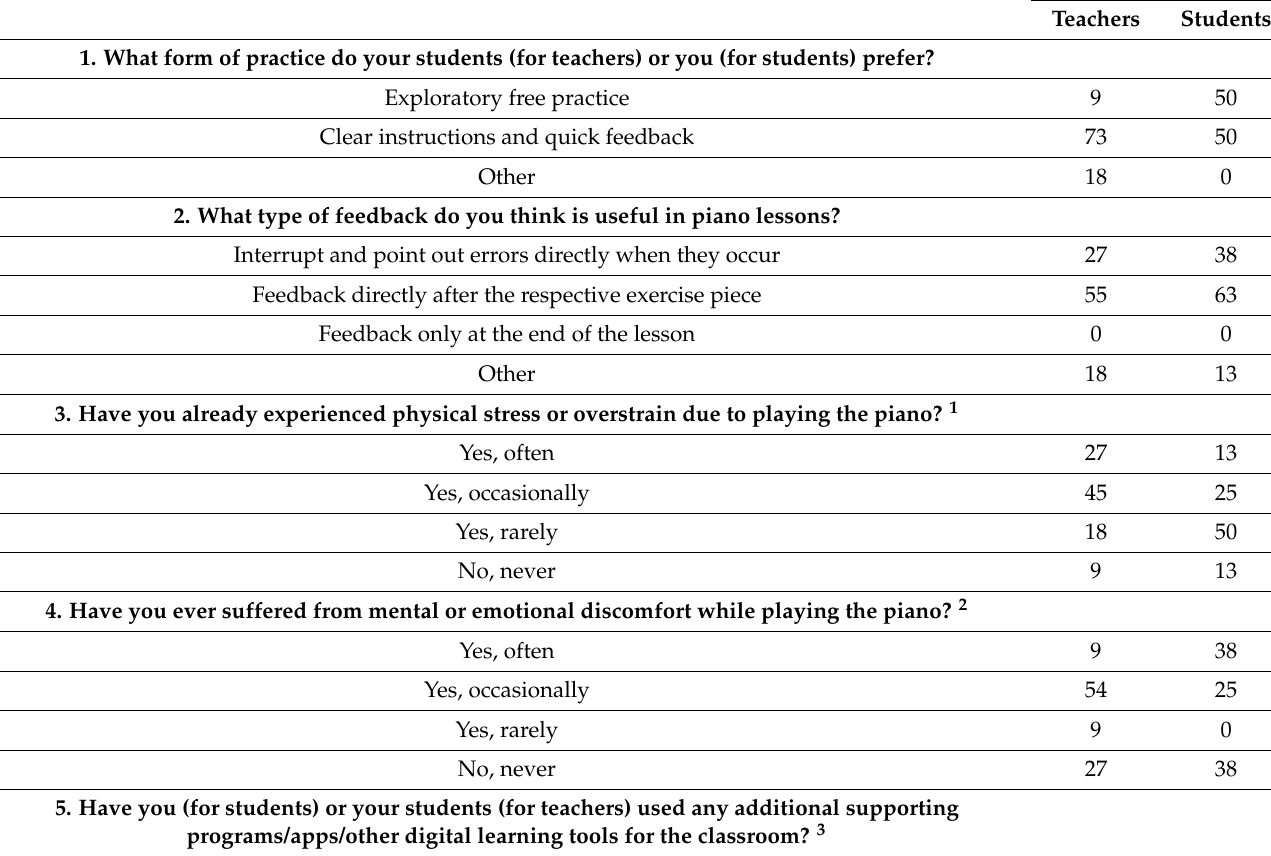
Table A1. Participants’ responses to questionnaire. Responses are presented as a percentage on questions relating to physical and psychological complaints as well as experiences with digital support systems and feedback preferences related to piano playing. Multiple answer choices were